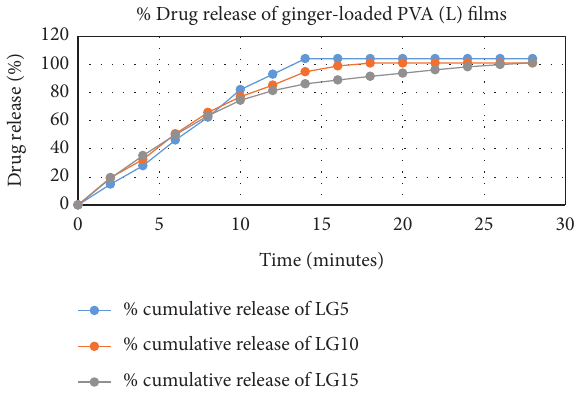
Figure 18: Drug release % of ginger-loaded PVA (L) films.